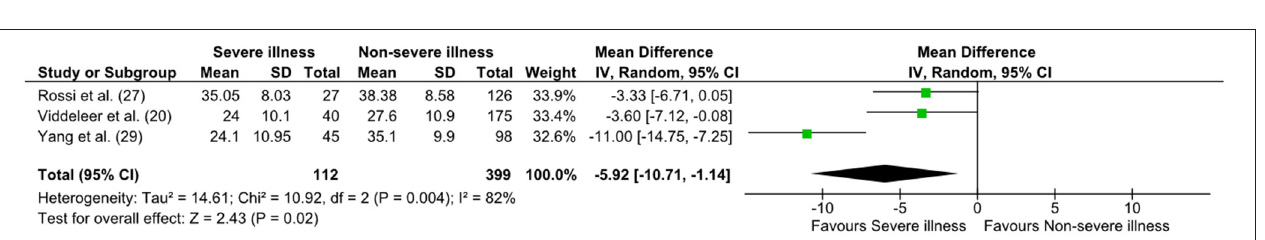
FIGURE 3 | The forest plot of SMI and survival rate. SD, standard deviation; CI, confidence intervals.